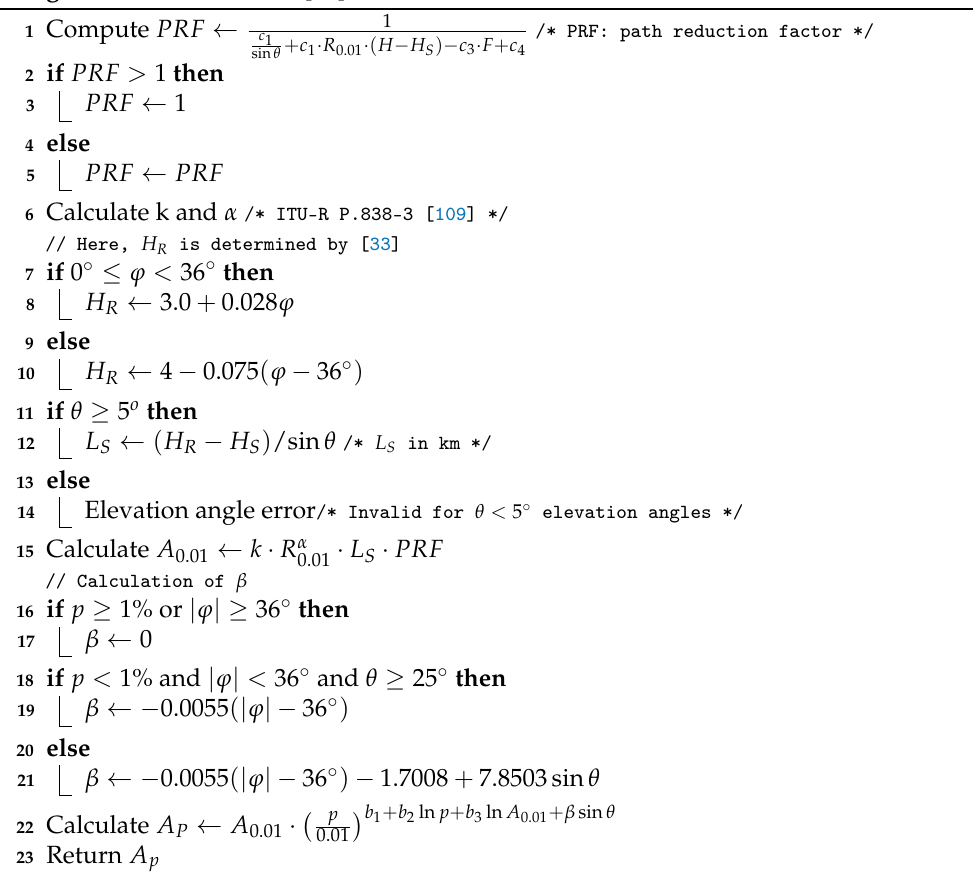
Algorithm 9: YLO Model